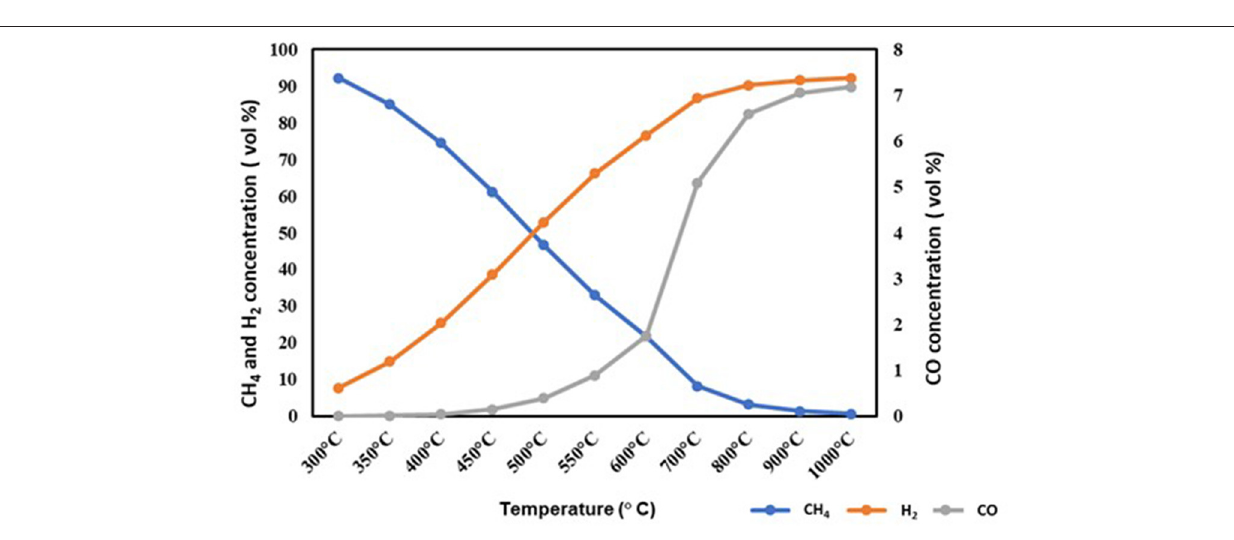
FIGURE 5 | Predicted gas species as a function of temperature with nitrogen